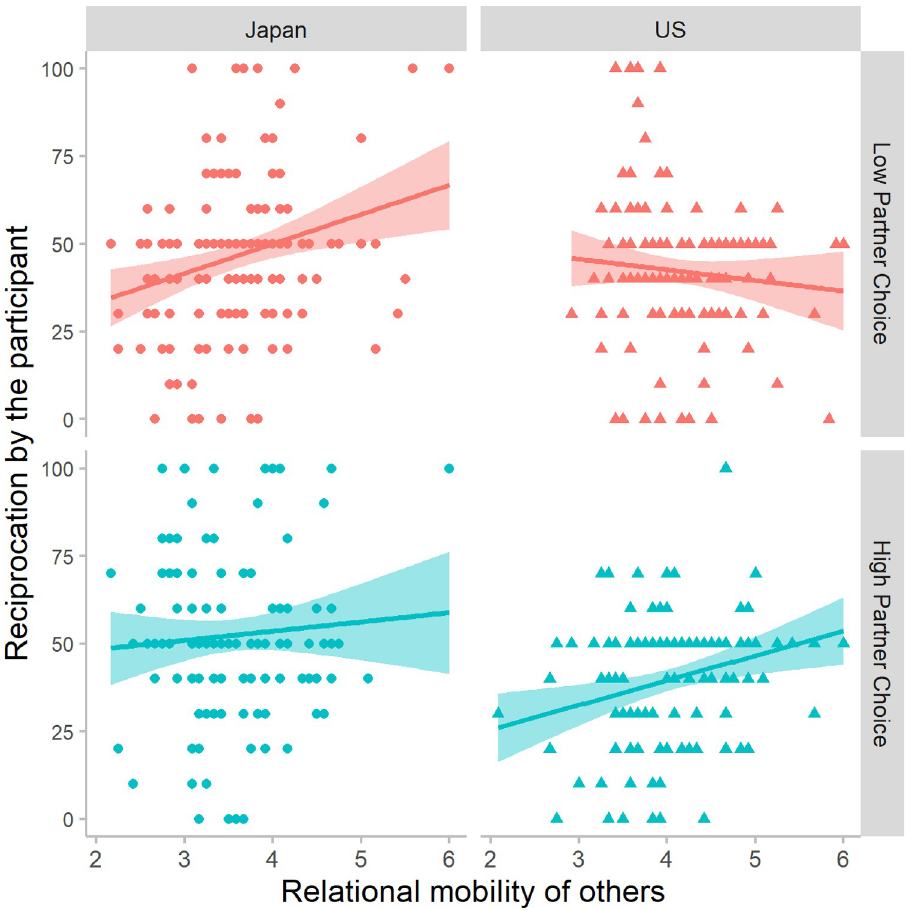
Fig 5. The effect of perceived relational mobility of others on reciprocation. Perceptions of other people’s relational mobility ( RM others ) was positively associated with the percentage of points the participant returned to the partner (0– 100%). The more they thought others could exercise partner choice, the more they